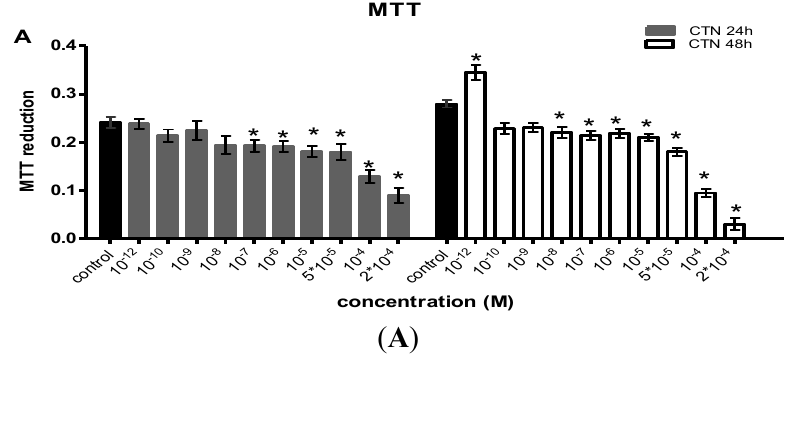
Figure 1. MTT reduction as a measure of metabolic activity in Hep3B cells after single administration of ( A ) citrinin (CTN) ( B ) ochratoxin Α (OTA) and ( C ) sterigmatocystin (STER), for 24 h and 48 h; Bars represent mean values of every concentration at each time point, which was evaluated at three individual experiments, performing measurements at a number of 8-plicates each time (8-plicates, n =